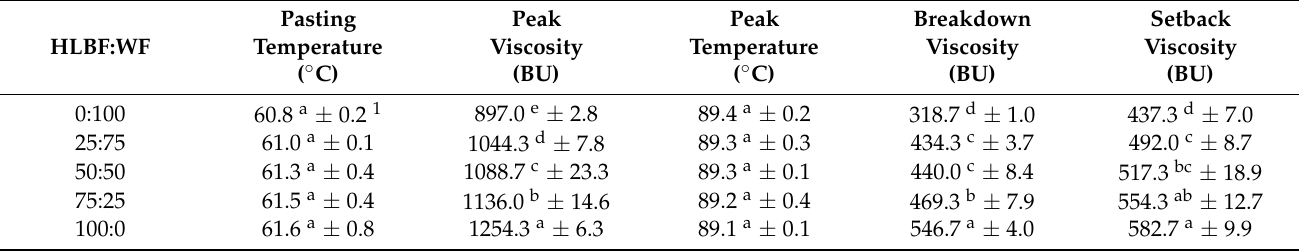
Table 1. Pasting properties of composite flours containing wheat flour (WF) and hulless barley flour